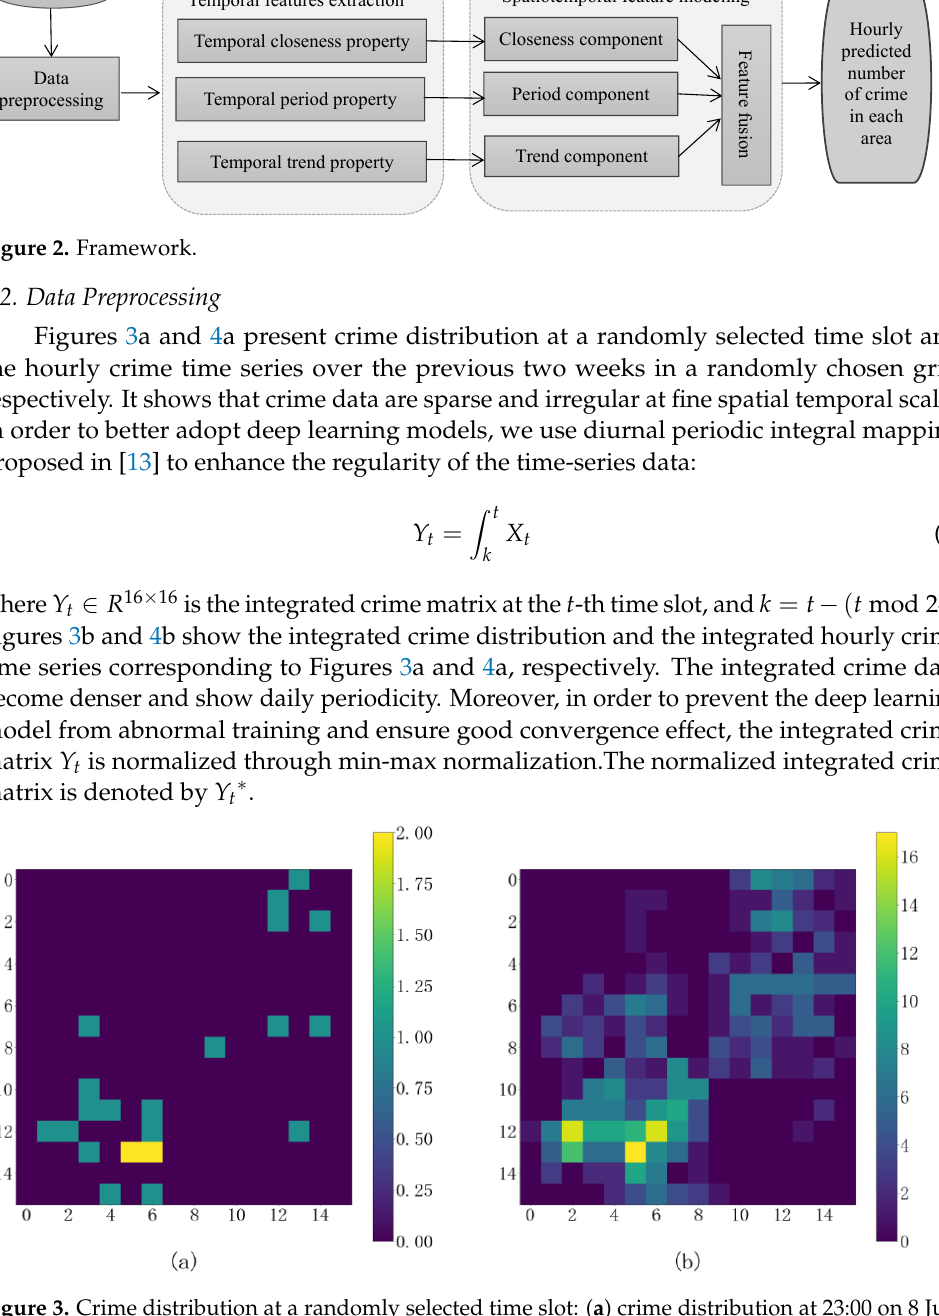
Figure 3. Crime distribution at a randomly selected time slot: ( a ) crime distribution at 23:00 on 8 July 2015; ( b ) integrated crime distribution corresponding to ( a